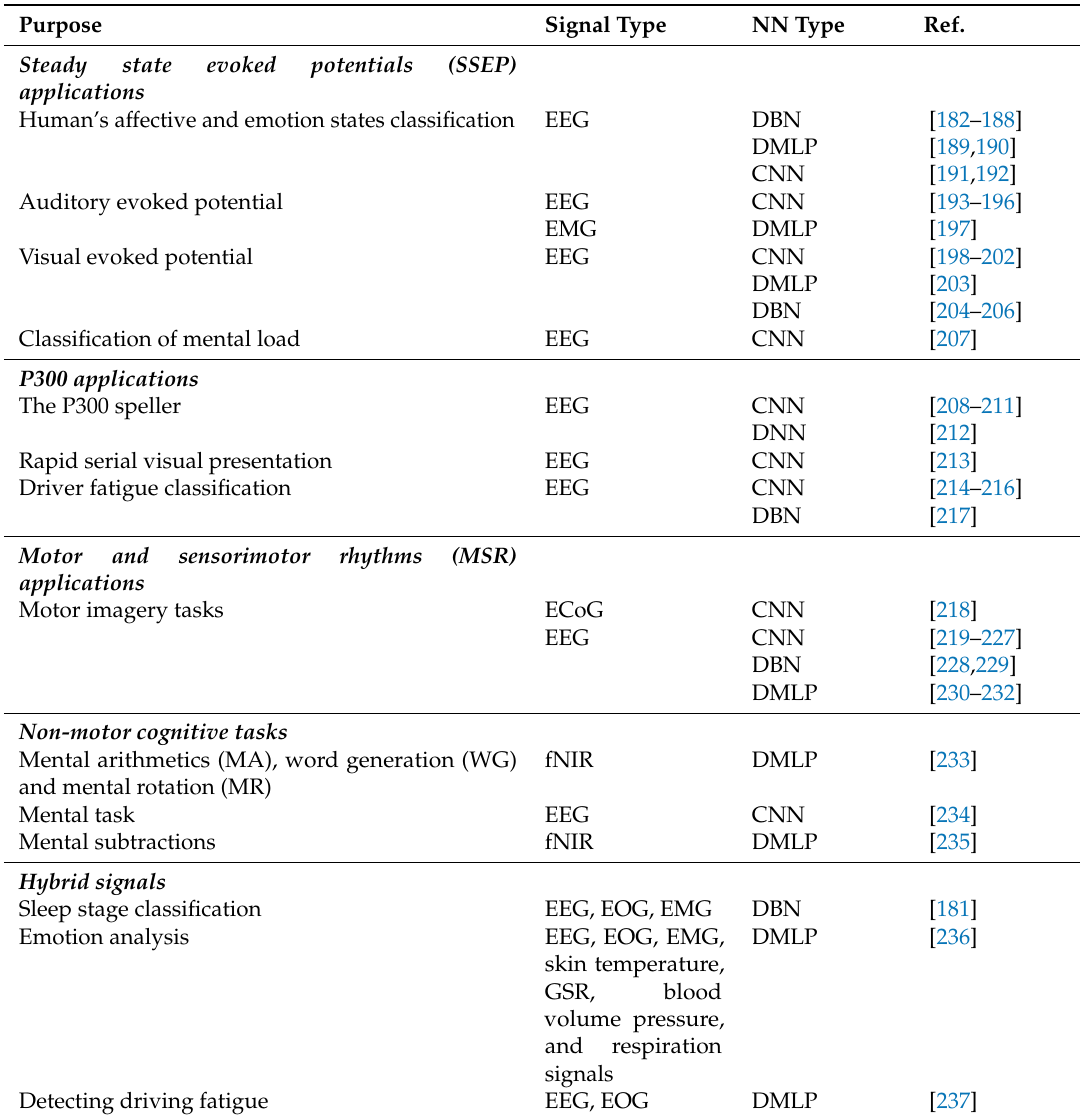
Table 4. Overview of papers using DL techniques for brain decoding